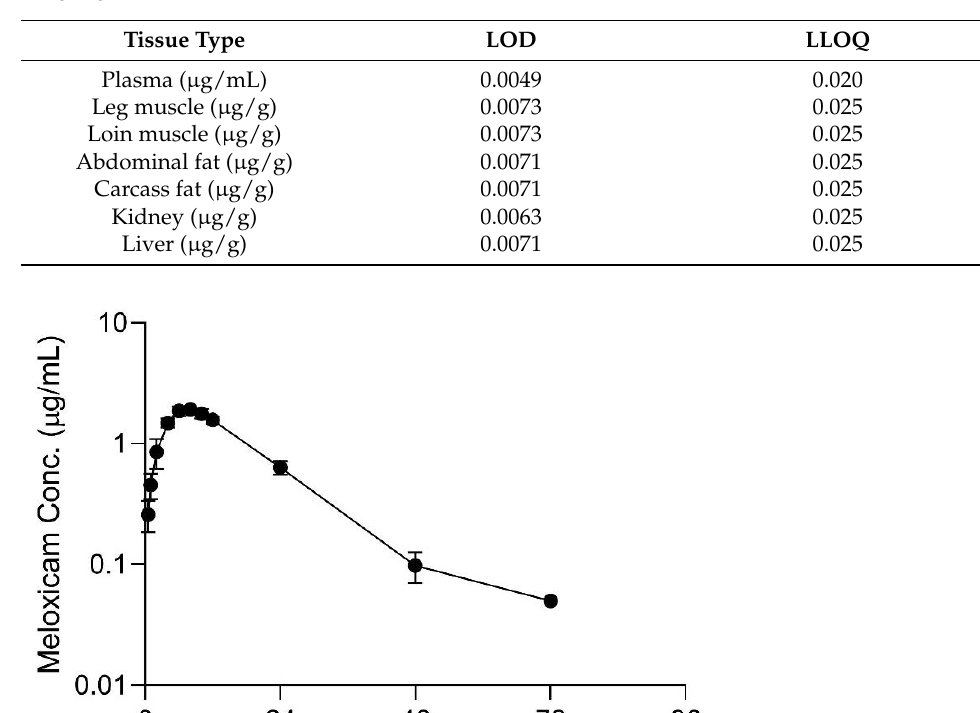
Table 3. Median (range) non-compartmental pharmacokinetic parameters estimated for sheep (n = 6) administered 10 daily oral 1 mg/kg doses of meloxicam.